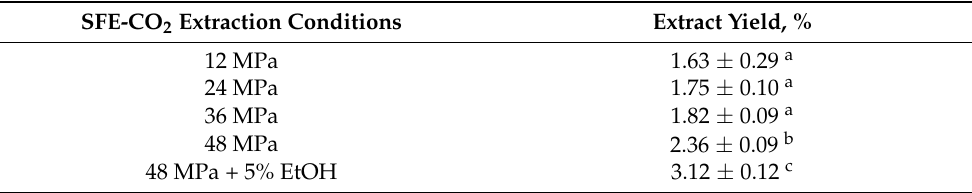
Table 1. SFE-CO 2 extraction conditions of Narcissus poeticus and obtained yields